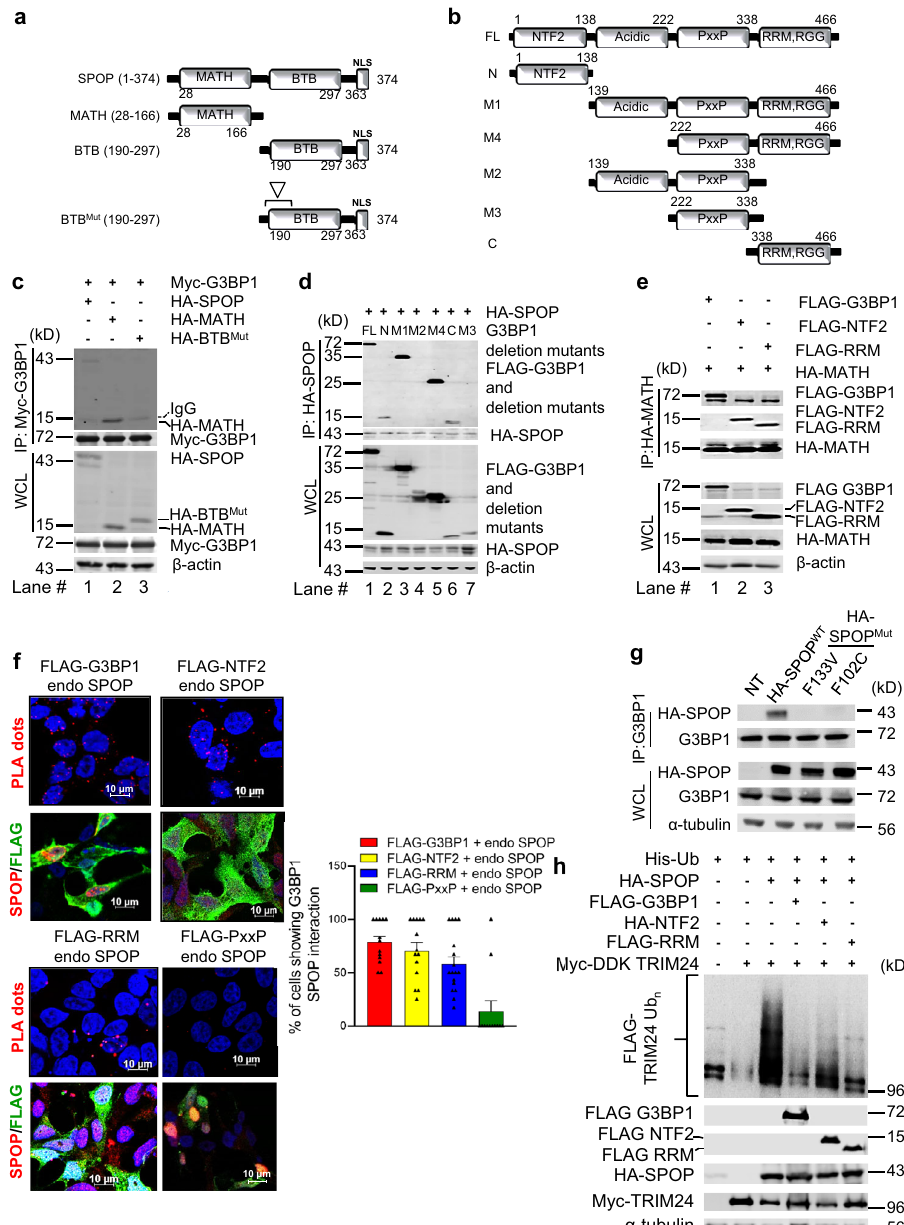
Fig. 2 Molecular determinants of crosstalk between G3BP1 and SPOP. a , b Schematic illustration of a series of SPOP deletion mutants and G3BP1 deletion mutants used in this study. “ Inverted triangle ” shows SPOP dimerization sites and mutations (L186D, L190D, L193D, I217K). c , d Immunoprecipitation and immunoblotting of WCL derived from HEK 293T cells transfected with the indicated full length (FL) or ( c ) SPOP or ( d ) G3BP1 deletion constructs. β -actin served as the loading control. HA-MATH: HA-tagged MATH domain of SPOP; HA-BTB Mut : HA-tagged BTB domain of SPOP with mutated dimerization sites; N: NTF2 (1-138 aa), M1: G3BP1 (139-466 aa), M4: G3BP1 (222-466 aa), M2: G3BP1 (139-338 aa), M3: G3BP1 (222-338 aa), C: RRM (338-466 aa). n = 3. e Immunoprecipitation and immunoblotting of WCL derived from 22Rv1 cells transfected with the indicated construct(s). n = 3. f PLA assay for the FLAG – G3BP1 and its deletion mutants with endogenous SPOP. Each red dot represents an interaction (scale bar, 10 μ m). Representative immuno fl uorescence images of 22Rv1 cells transfected with FLAG-G3BP1, FLAG-NTF2, FLAG-RRM, or FLAG-PxxP. A graph showing percentage of cells with G3BP1 and SPOP interaction. n = 3 biologically independent experiments. Error bars, ±S.E.M. g Parental 22Rv1 cells were transfected with either HA-SPOP WT or HA-SPOP F133V or HA-SPOP F102C . After 48h, cell lysates were immunoprecipitated with anti-G3BP1 antibody and immunoblotted with either anti-HA-SPOP or anti-G3BP1 antibody. NT no transfection. n = 3. h HEK 293T cells were transiently transfected with the indicated construct(s) for 48h. Ni-NTA pull-down products or WCL were blotted for the indicated proteins. α -tubulin serves as the loading control. n = 3. Source data are provided as a Source Data fi le. WCL whole cell sgG3BP1 cell line, FLAG-G3BP1 NTF2 was still capable of co- RGG domains of G3BP1 bind to the MATH domain of SPOP immunoprecipitating with HA-SPOP, indicating that G3BP1 NTF2 (Fig. 2e). In fact, several clinically relevant SPOP mutants have interacts with SPOP independent of G3BP1 homo-dimerization been identi fi ed and we observed that G3BP1 can interact with (Supplementary Fig. 2B). Furthermore, both the NTF2 and RRM- SPOP WT but not with SPOP F133V and SPOP F102C (Fig. 2g).